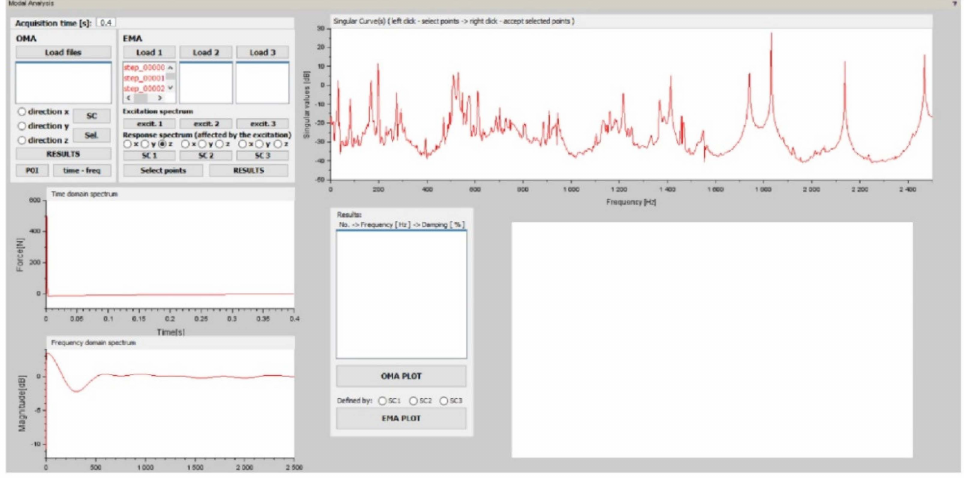
Figure 12. Singular